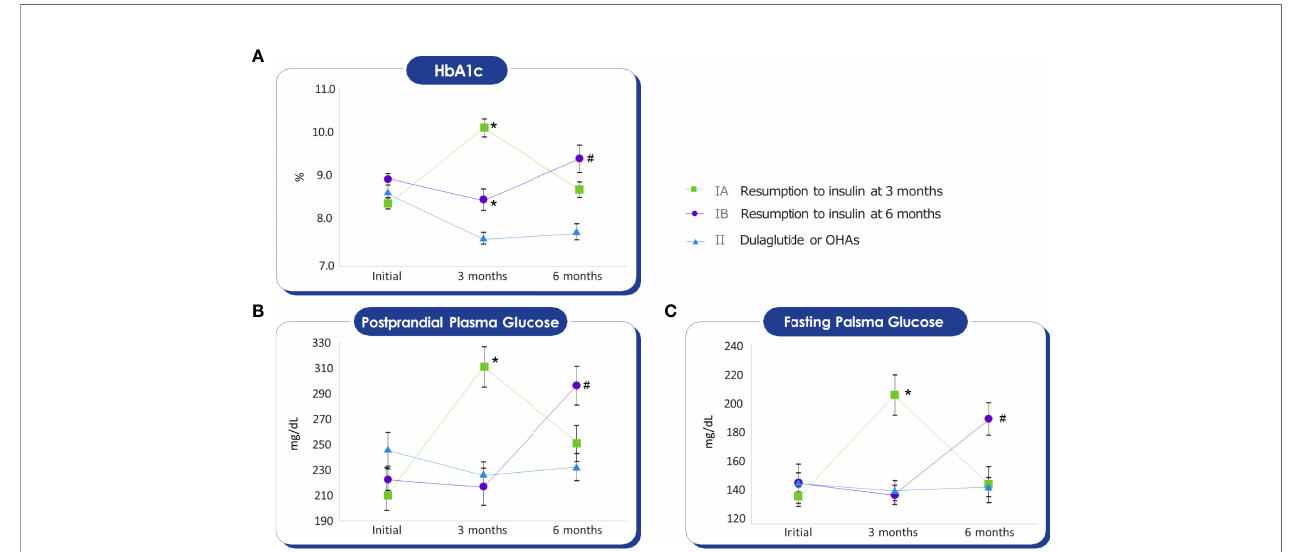
FIGURE 2 | Mann-Whitney test was conducted to compare the average of the glycemic parameters with Group II. Initial HbA1c, Fasting glucose, Postprandial glucose values do not show differences between groups. (A) HbA1c of Group IA, IB at three months, and HbA1c of Group IB at six months were higher than Group